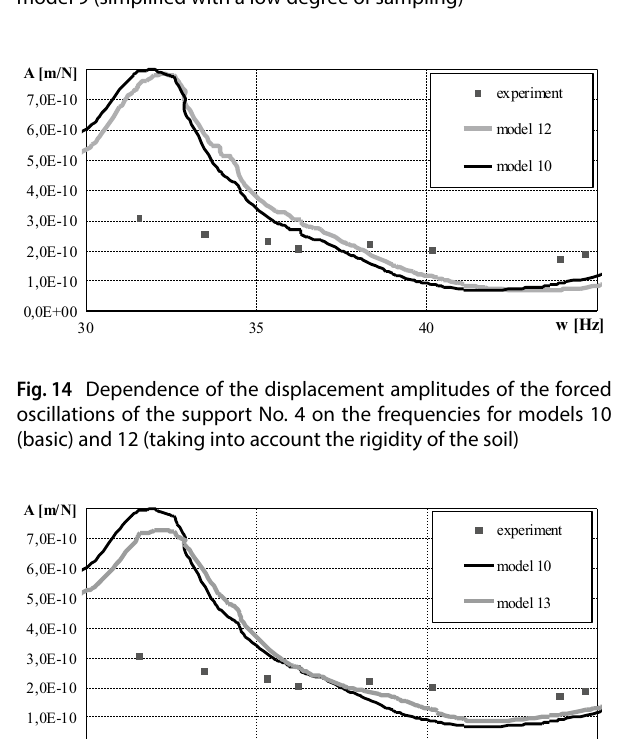
Fig. 13 Dependences of the displacement amplitudes of the forced oscillations of the supports No. 3, 4, 5 on the frequencies for the model 9 (simplified with a low degree of sampling)